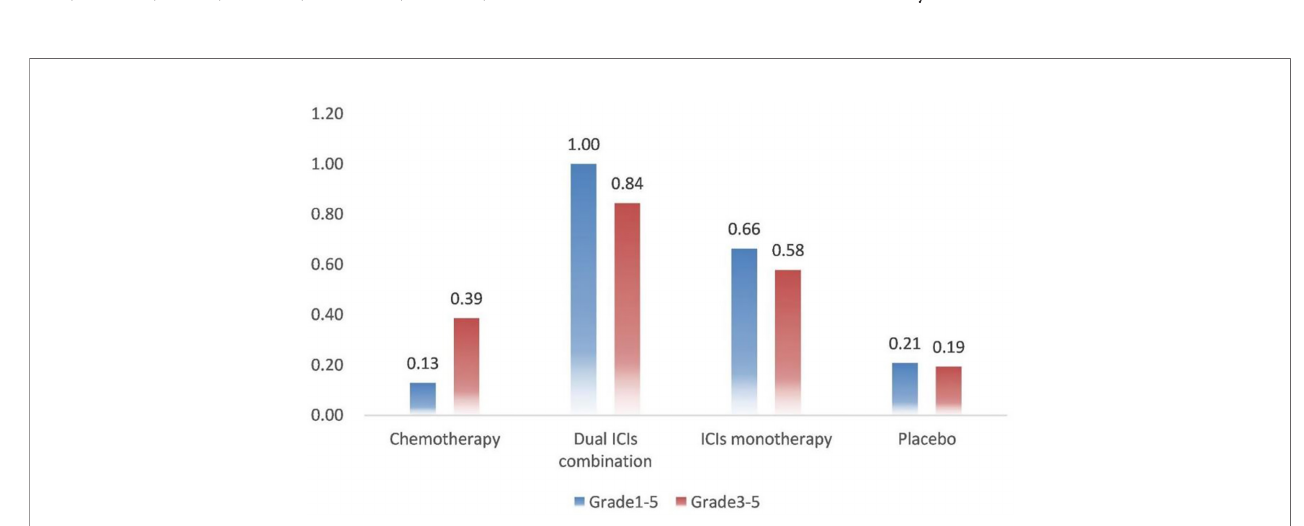
FIGURE 3 | Rank probabilities with SUCRA value for IRP in four treatment groups based on the network consistency model. Higher SUCRA scores are correlated with higher risk of IRP. SUCRA, surface under the cumulative ranking curve.